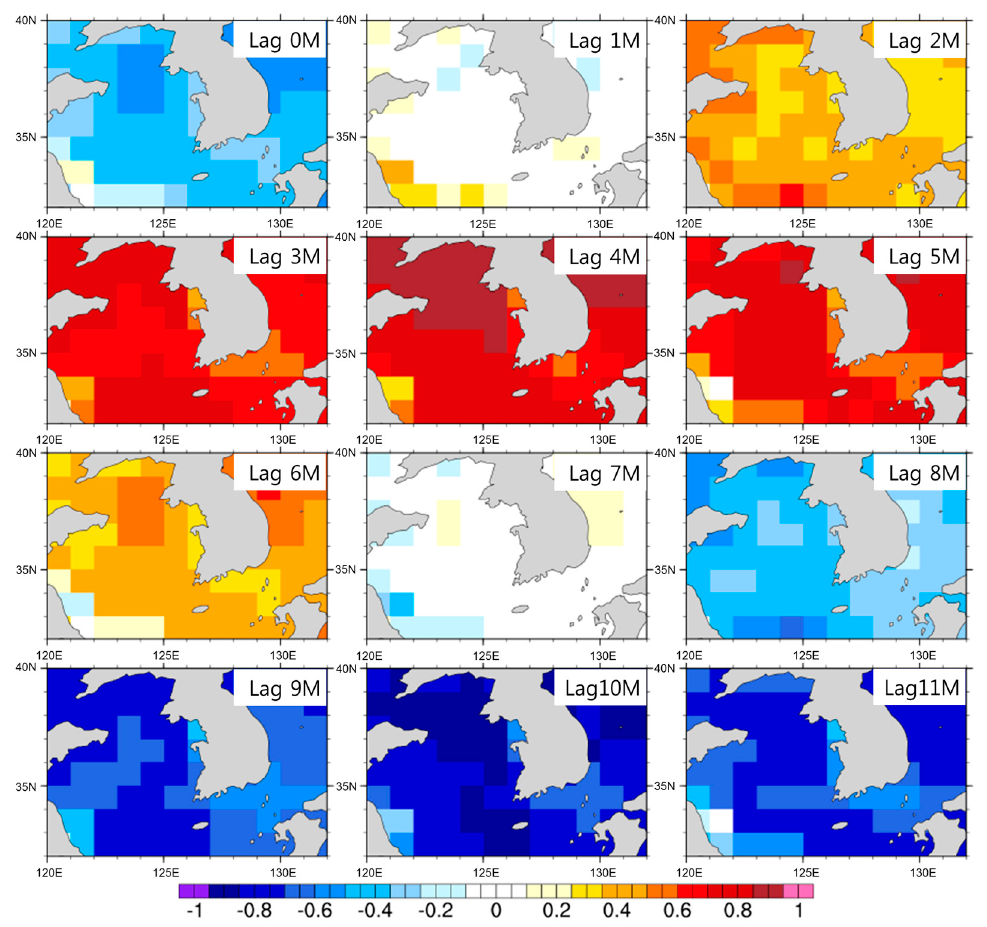
Figure 6. Spatial distribution of the autocorrelation coefficient up to the eleven-month time lags in the OISST and QSCAT wind speeds over offshore regions during the model construction period.